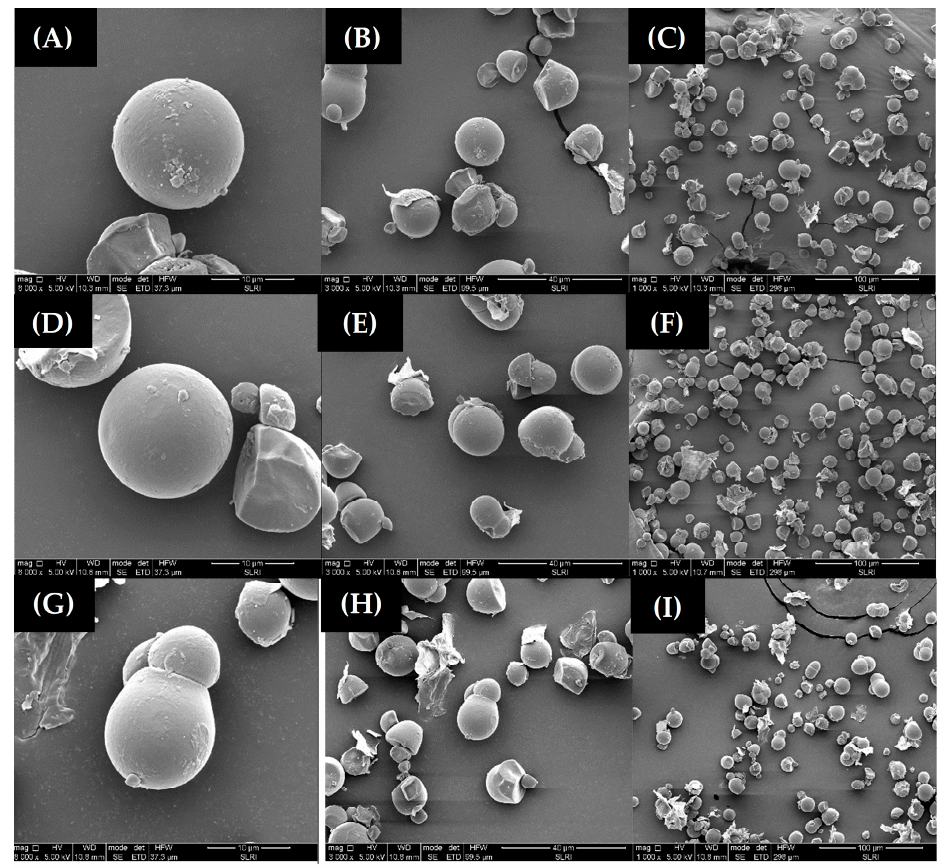
Figure 3. Characteristics of cassava flour granules, Pirun 6 ( A – C ), Pirun 4 ( D – F ), Pirun 2 ( G – I ) were photographed under a scanning electron microscope (SEM) at 1000× ( C , F , I ) 3000× ( B , E , H ) and 8000× ( A , D , G ).